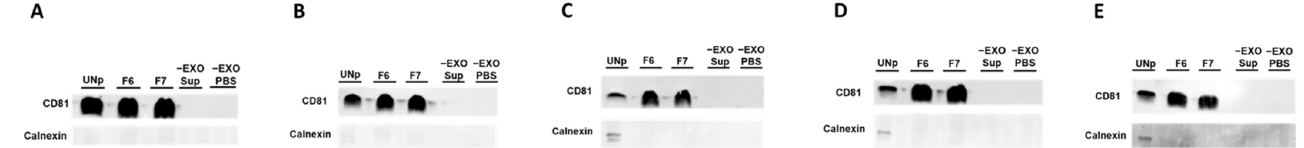
Figure 2. Human urinary exosomal preparations characterized by immunoblotting. ( A – E ) Human urine was collected from subjects listed in Table 1. Immunoblotting of lysates of human urinary particles isolated using ultracentrifugation and remaining unpurified (UNp) or isolated via ultra- centrifugation and then fraction 6 (F6) and fraction 7 (F7) collected by SEC column-purification. Immunoblotting controls were exosome-depleted human urine (–EXO Sup) and PBS used to wash exosomal preparations (–EXO PBS). Blots were probed for the exosome-positive marker CD81 and exosome-negative marker calnexin.